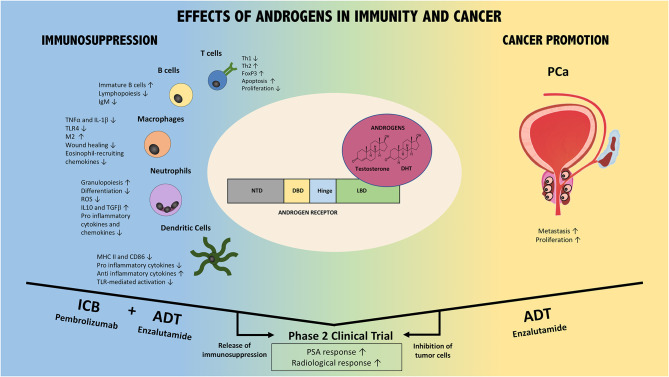
Effects of AR/Androgen signaling in immunity and prostate cancer. AR/androgens can influence different immune cell subsets, including T cells, B cells, macrophages, neutrophils, and dendritic cells (Left part of the figure). Overall, their effect is immunosuppressive. In addition, androgens/AR directly and indirectly promote prostate cancer (PCa) via different mechanisms (Right part of the figure). Thus, the combination of ADT with immune checkpoint blockade could foster anti-tumor immune responses (ICB+ADT) while ADT additionally inhibits PCa directly. This combination strategy has resulted in improved patient responses compared to either monotherapy in Phase 2 clinical trials. Confirmatory Phase 3 trials are warranted and ongoing. NTD, N-terminal domain; DBD, DNA binding domain; LBD, ligand biding domain; DHT, dihydrotestosterone; ADT, androgen deprivation therapy; ICB, immune checkpoint blockade; PCa, prostate cancer; PSA, prostate specific antigen.